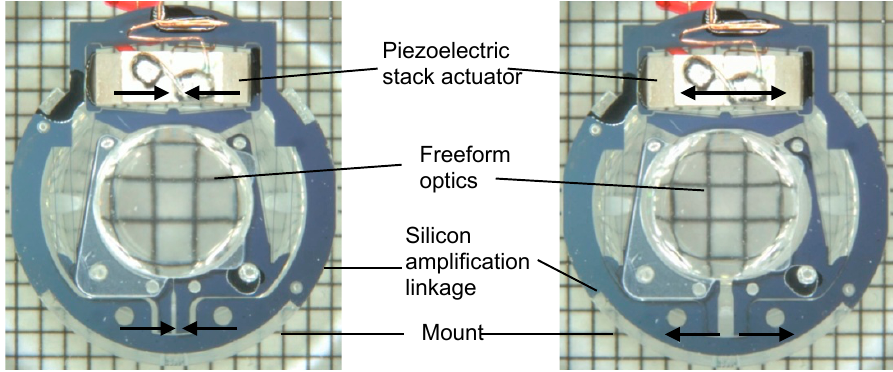
Figure 5. Optical micromachine and its components: Tunable freeform optics, silicon linkage, and piezoelectric stack actuator [1]. Left : contracted actuator and accommodated state, right : expanded actuator and disaccommodated state of the optics.